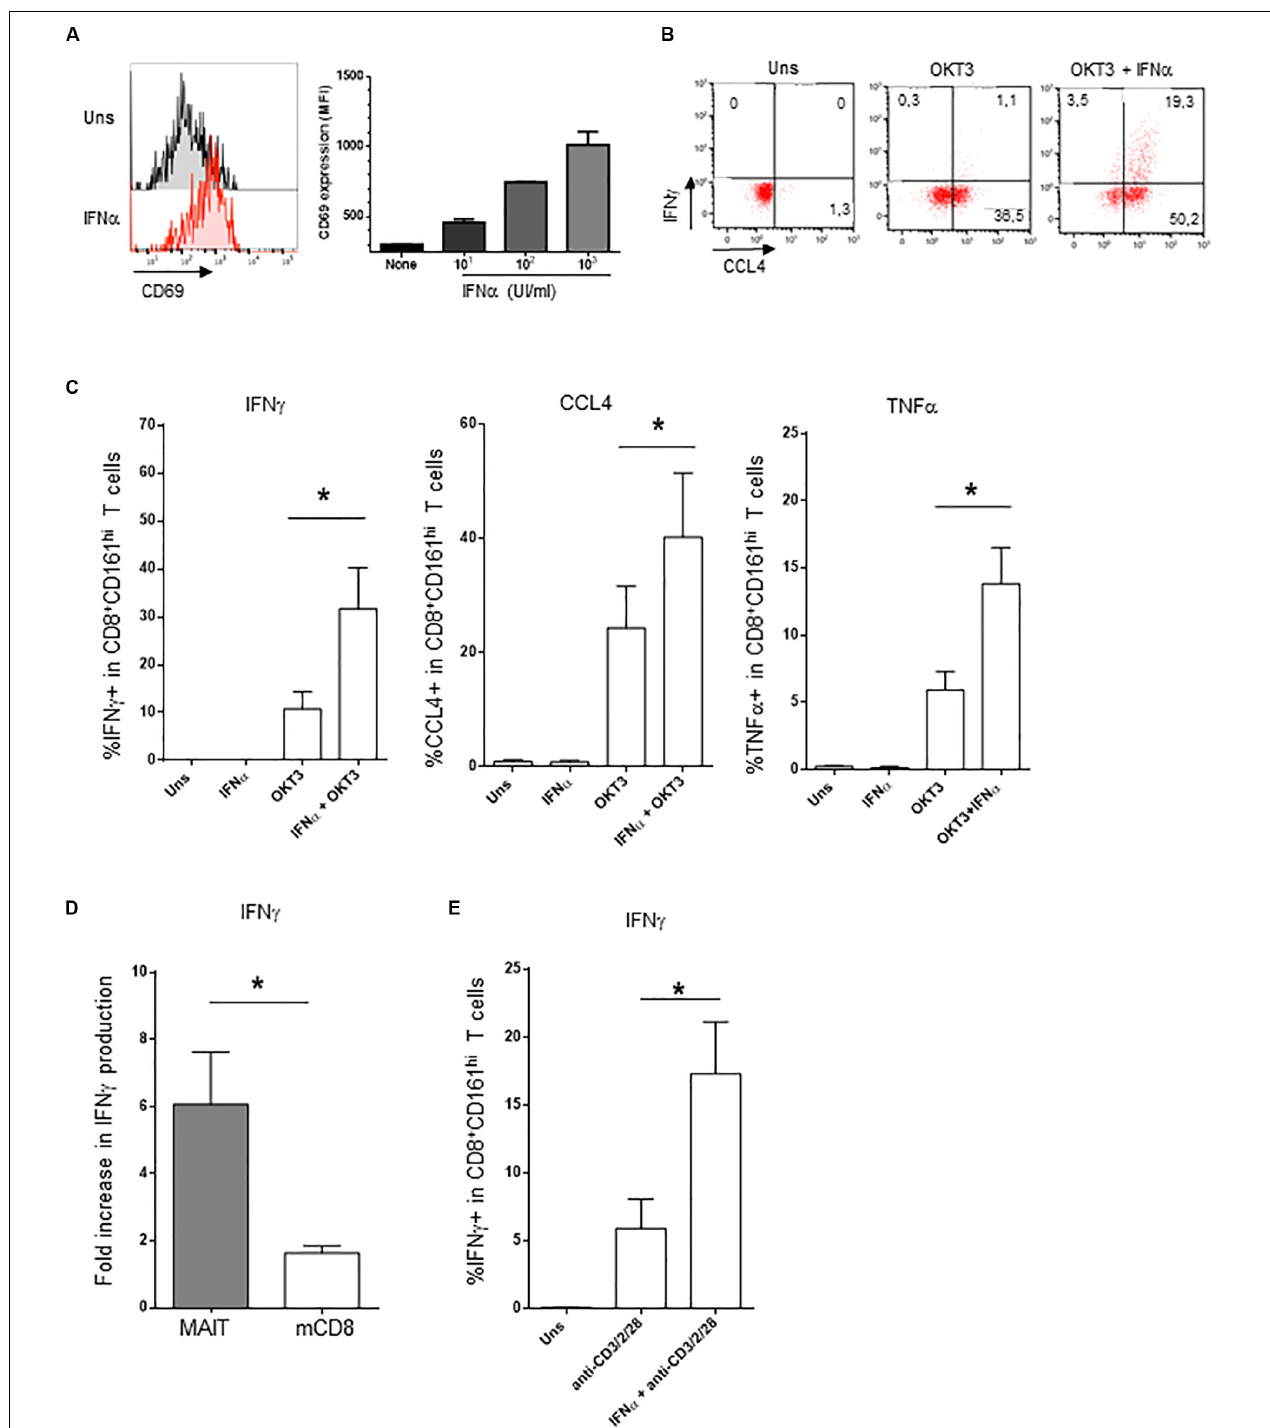
FIGURE 2 | Co-stimulation of CD161 hi CD8 + T cells activation by IFN α 2b. (A) Left panel: representative example of membrane CD69 expression by CD161 hi CD8 + T cells left unstimulated (upper panel) or stimulated for 20 h with 1000 IU/ml of rIFN α 2b (lower). Right panel: dose-response of CD69 expression by CD161 hi CD8 + T cells with increasing doses of rIFN α 2b. (B) Representative example of intracellular IFN γ and CCL4 production by CD161 hi CD8 + T cells left unstimulated or after stimulation with the indicated stimuli. (C) Cumulative frequencies (mean ± SEM) of intracellular IFN γ + (left), CCL4+ (middle), and TNF α + (right) CD161 hi CD8 + T cells treated as in (B) , n = 6. (D) Ratio (mean ± SEM) of IFN γ + cells after OKT3 + IFN α 2b stimulation to OKT3 stimulation alone, in CD161 hi CD8 + T and conventional memory CD8 T cells. (E) Intracellular IFN γ production (mean ± SEM) by purified MAIT cells left unstimulated or stimulated with anti-CD3/CD2/CD28 tetrameric antibodies alone or in combination with IFN α 2b, n = 4. Mann–Whitney test was used to compare frequencies. * p < 0.05; ns, not significant.